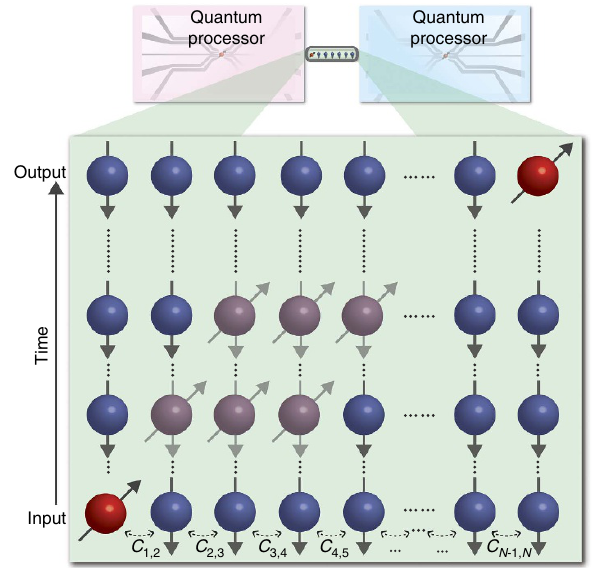
Figure 1 | Illustration of a one-dimensional perfect state transfer lattice connecting two quantum processors. By engineering the Hamiltonian of a lattice, the state at the first site is transferred to the last site after a specific time. This Hamiltonian defines the perfect state transfer protocol 3 , which can be used for routing quantum information inside a quantum